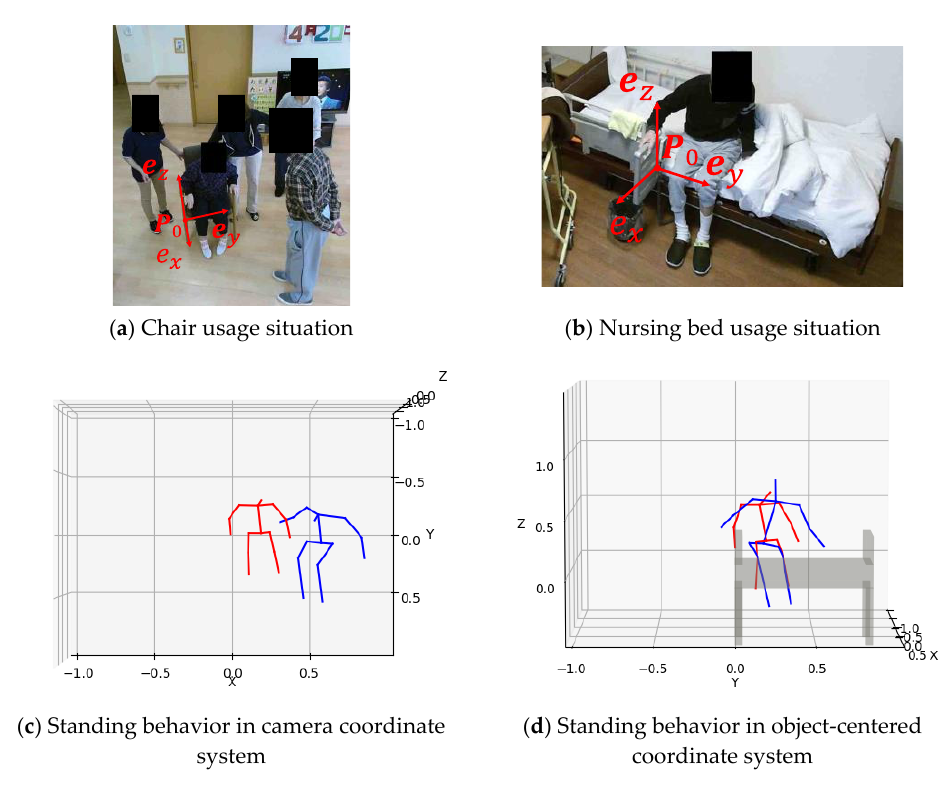
Figure 4. Comparison of two elderly persons standing behavior expressed in camera coordinate system and object-centered coordinate systems: red, chair usage case; blue, bed usage situation.